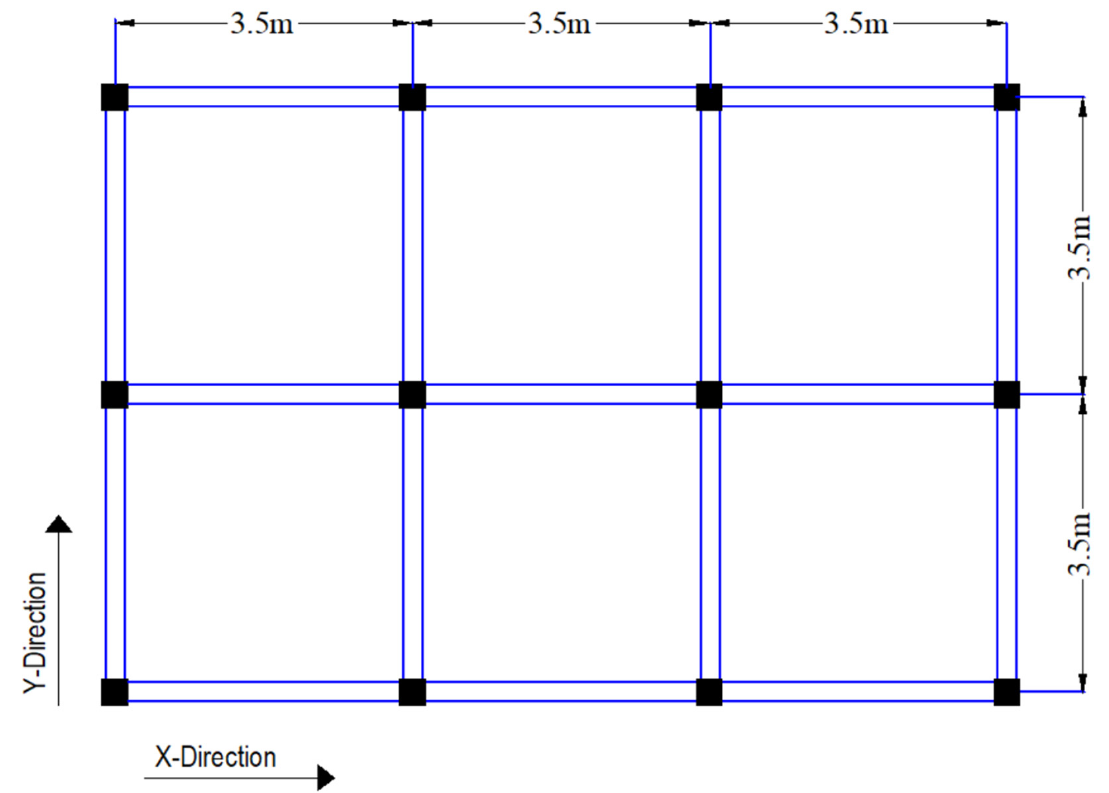
Figure 2. Typical floor plan of the case study building.